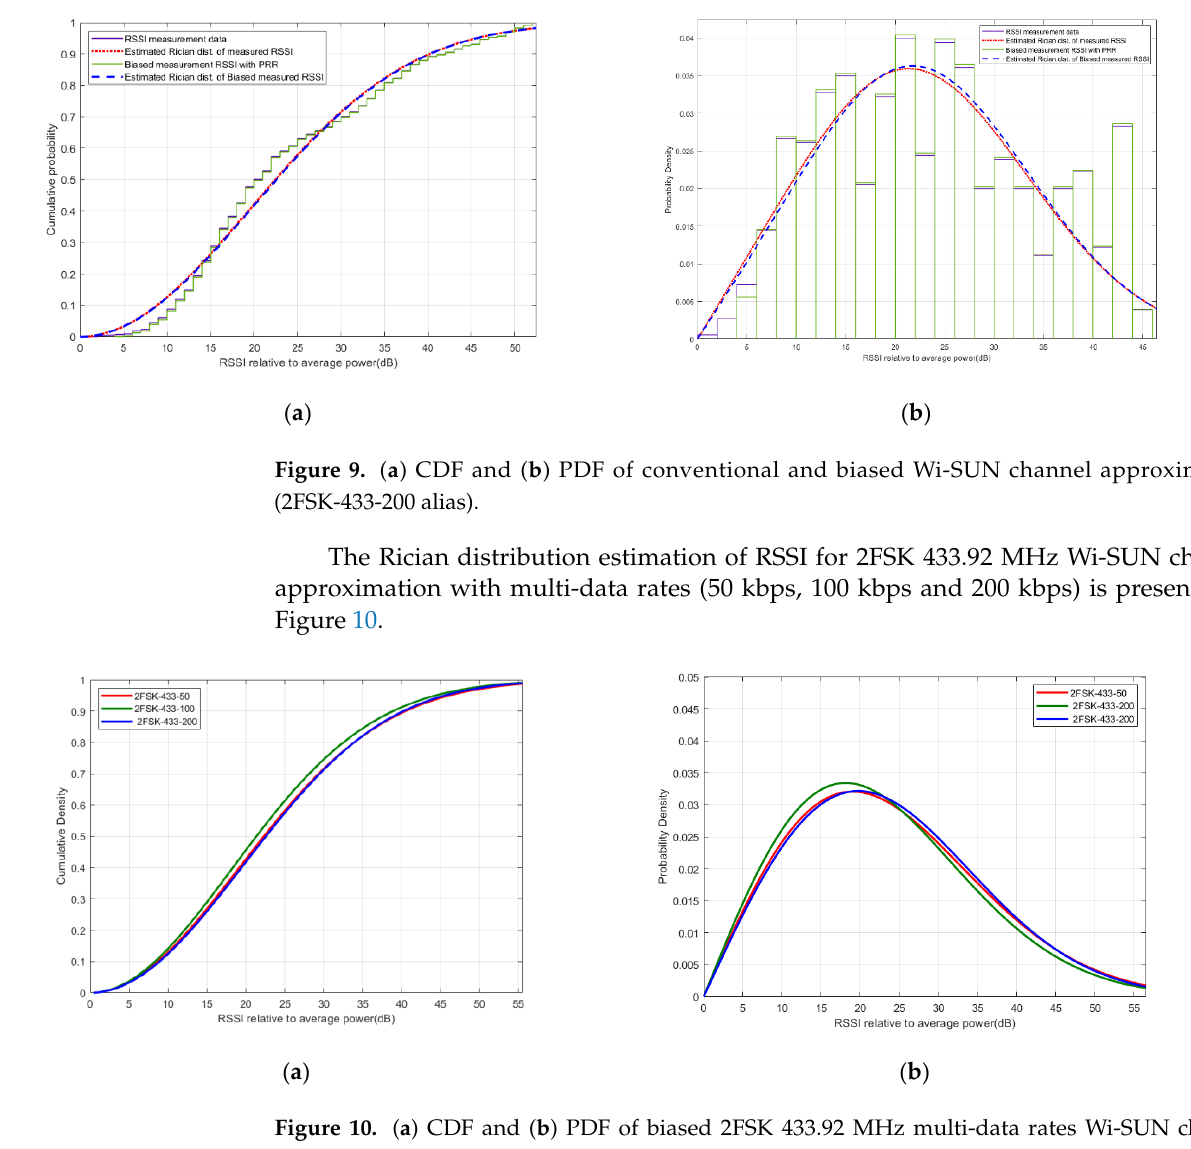
Table 4. Conventional fitted Rician parameter.